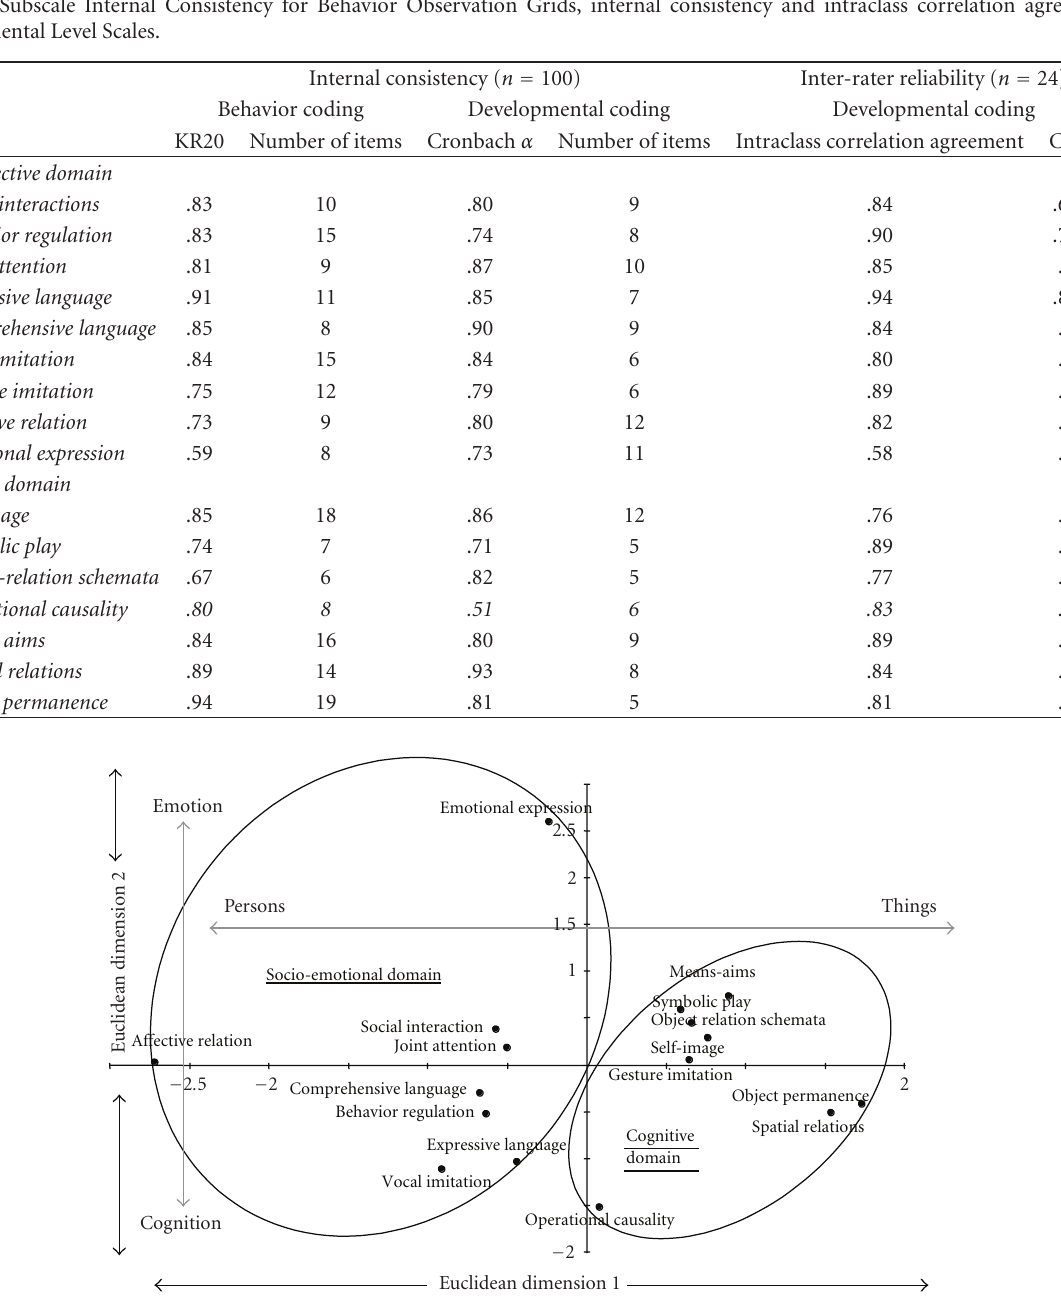
Figure 2: Configuration of SCEB Scores: Plans 1 &